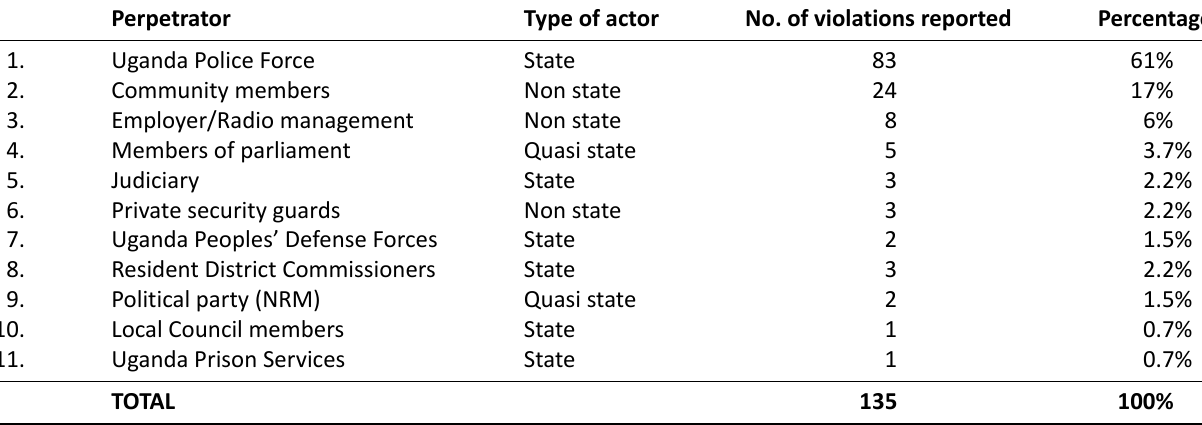
Table 1. Perpetrators of media freedom